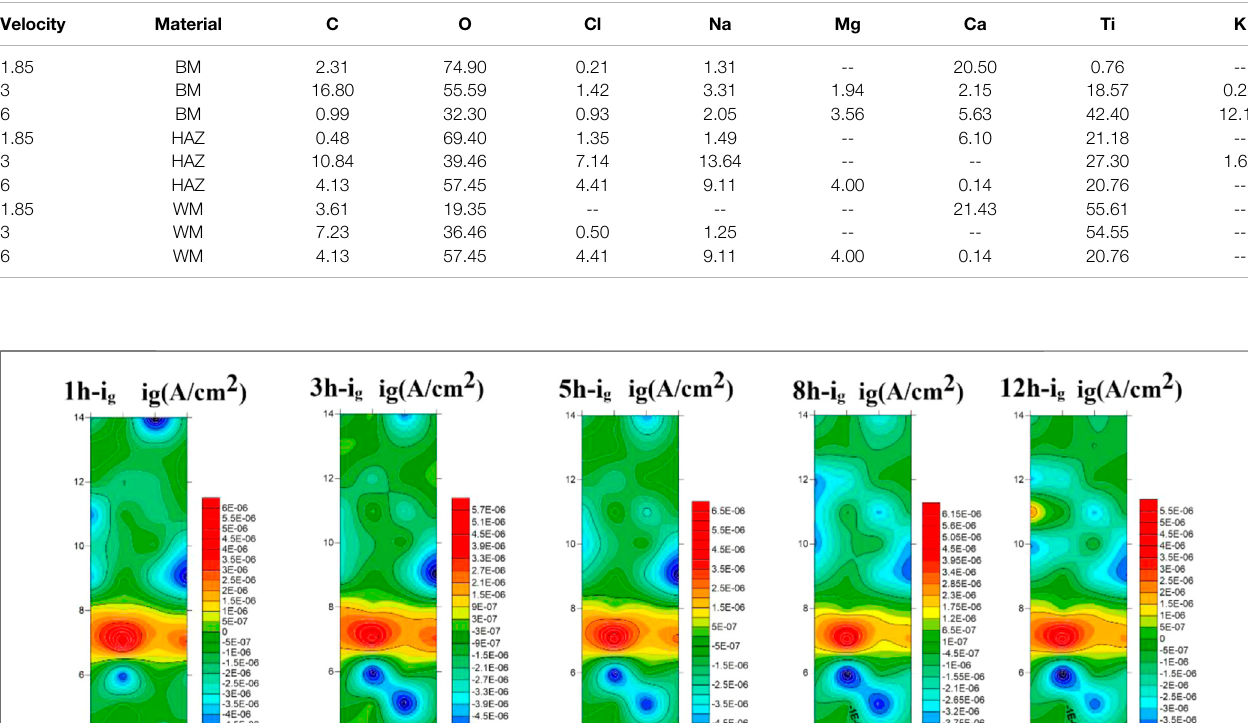
TABLE 4 | EDS test results of the material surface.